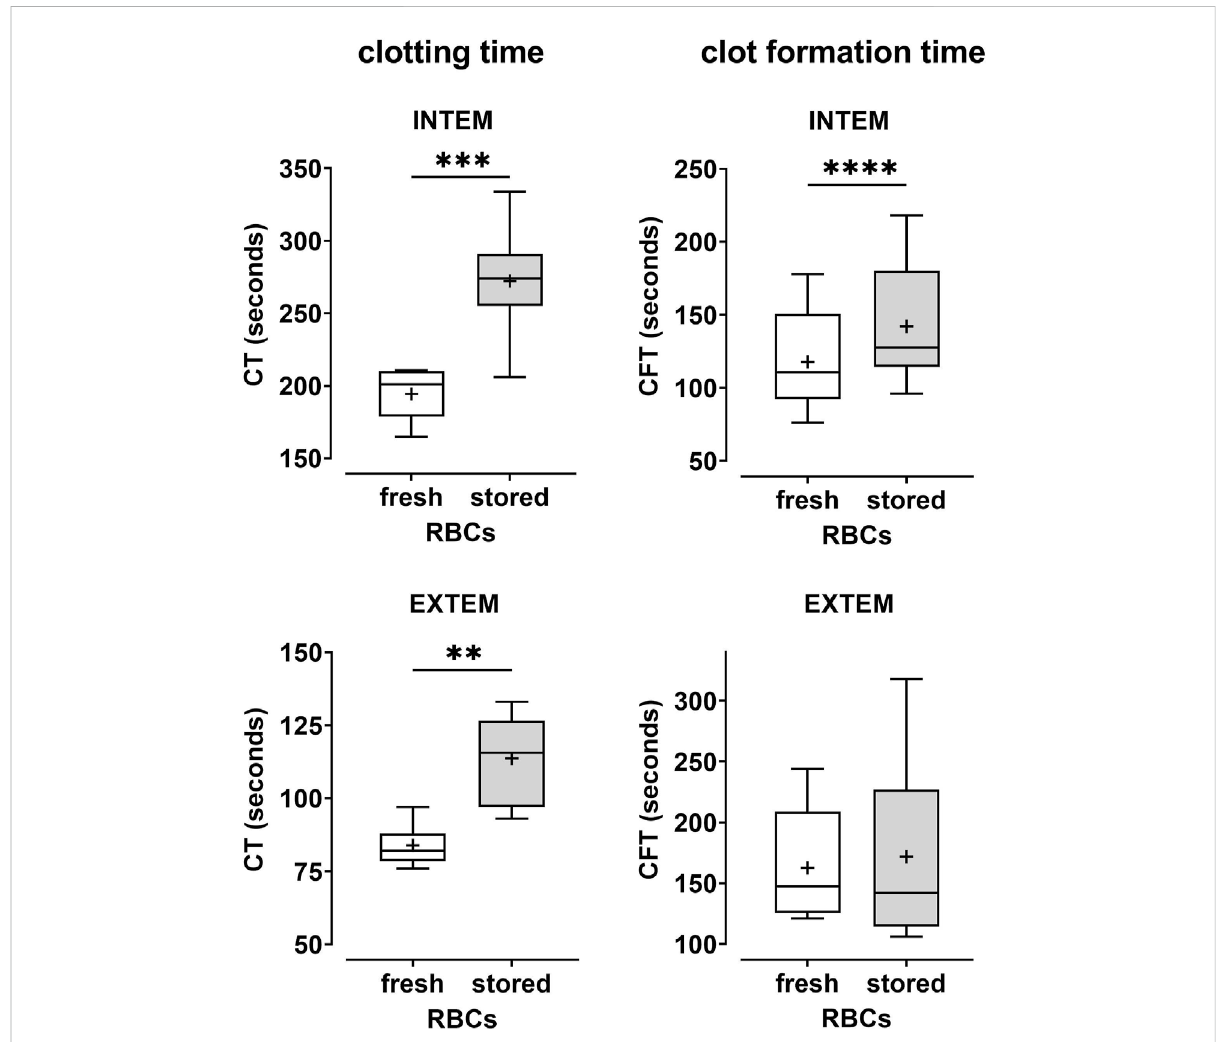
FIGURE 2 Coagulability is reduced in samples reconstituted with erythrocytes from stored PRBCs as compared to fresh erythrocytes. Freshly prepared PRP (PRP1 as described in the text) from healthy donors was combined with fresh autologous erythrocytes or with erythrocytes from AB0- and rhesus-matched PRBC units that had been stored for 5 – 6 weeks. Reconstituted blood samples were tested by thromboelastometry applying both INTEM and EXTEMassays. Clotting times (CT) and clot formation times (CFT) are shown in Box Whisker blots with the mean values indicated by crosses. Statistically signi fi cant differences were assessed by paired t-tests and indicated by stars (** p ≤ 0.01; *** p ≤ 0.001). Numerical values are given in Table 2 (note that this data set corresponds to blood samples reconstituted with